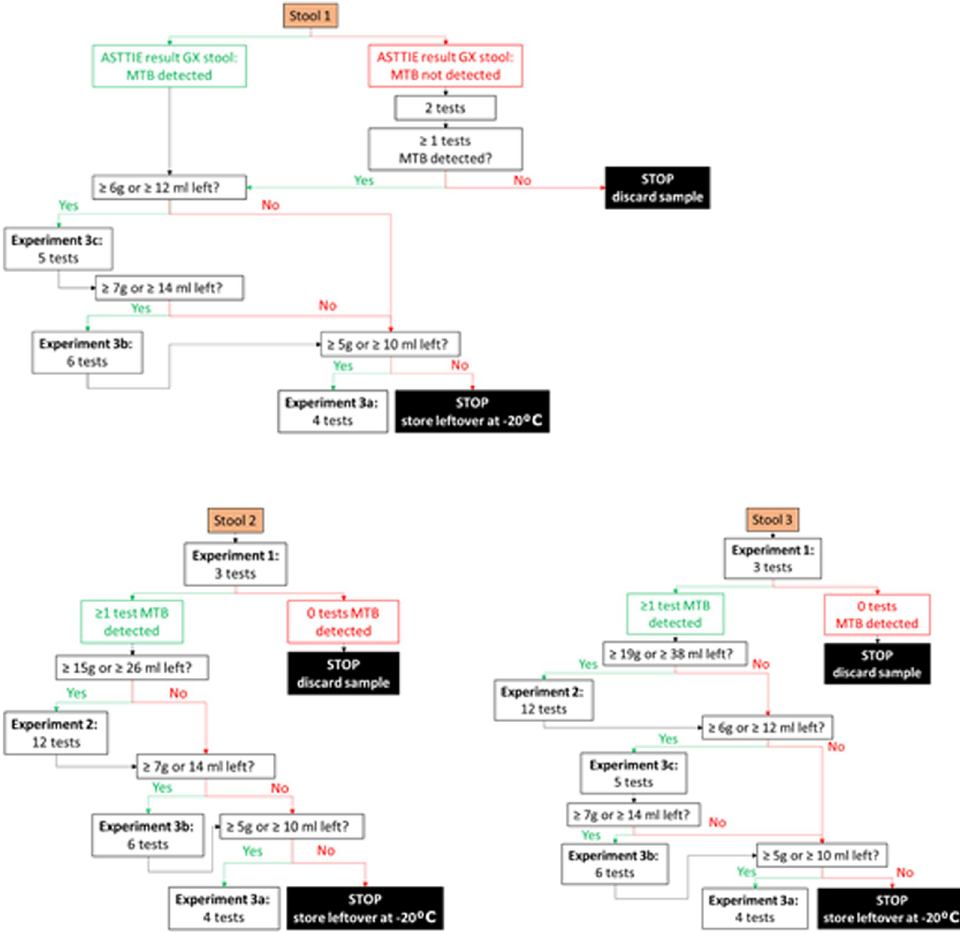
Sputum Testing for Tuberculosis in Indonesia and Ethiopia, MTB: M . tuberculosis , GX; GeneXpert, Exp.: Experiment; g, gram: ml, milliliter. Explanation of experiment numbers: Experiment 1: Stool sampling strategy; Experiment 2: Stool sample storage conditions; Experiment 3a: incubation time and shaking method; Experiment 3b: time and temperature for keeping the processed stool-sample reagent mixture; Experiment 3c: stool